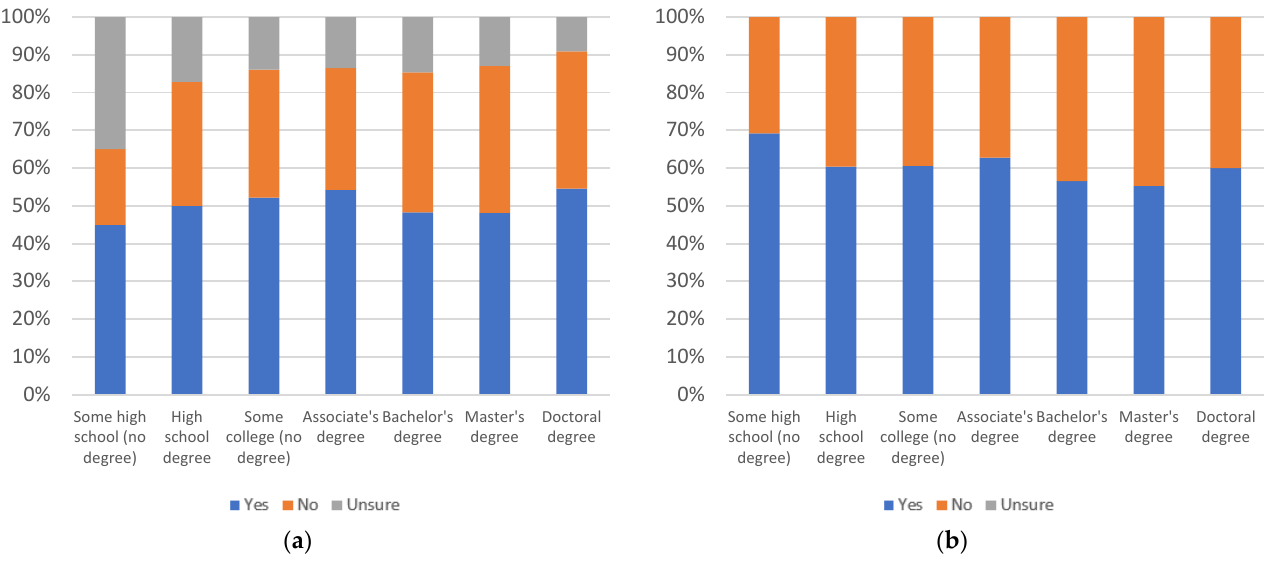
Figure 108. Label use, by education level: ( a ) with uncertain respondents (left) and ( b ) without uncertain respondents (right).